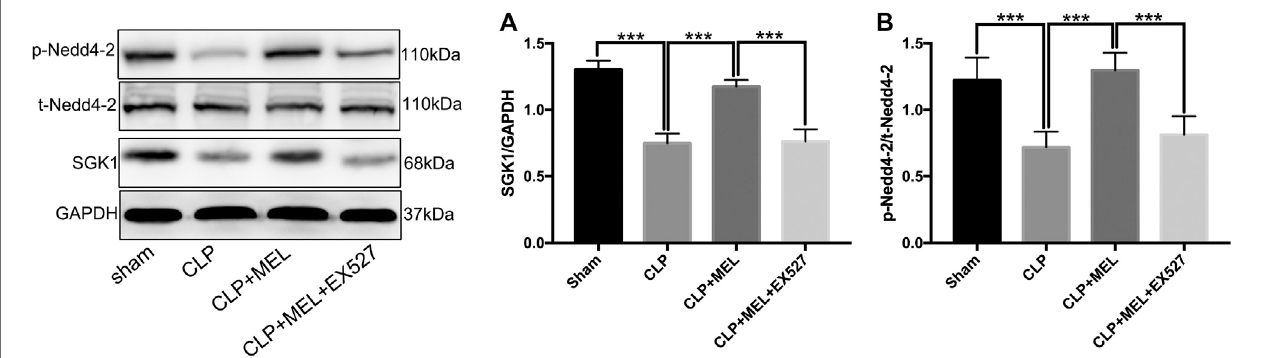
FIGURE 5 | SGK1/Nedd4-2 pathway contributed to the effect of melatonin. The protein expressions of SGK1, p-Nedd4-2 and t- Nedd4-2 were examined by western blot. (A) Theband intensityof SGK1 wasquantitated by normalized forGAPDH (B) Phosphorylated Nedd4-2 was quantitated by normalized for total Nedd4-2. The data are presented as the means ± SD ( n (cid:1) 6 – 8). *** p < 0.001; ** p < 0.01; * p < 0.05 (one-way ANOVA followed by Turkey post hoc